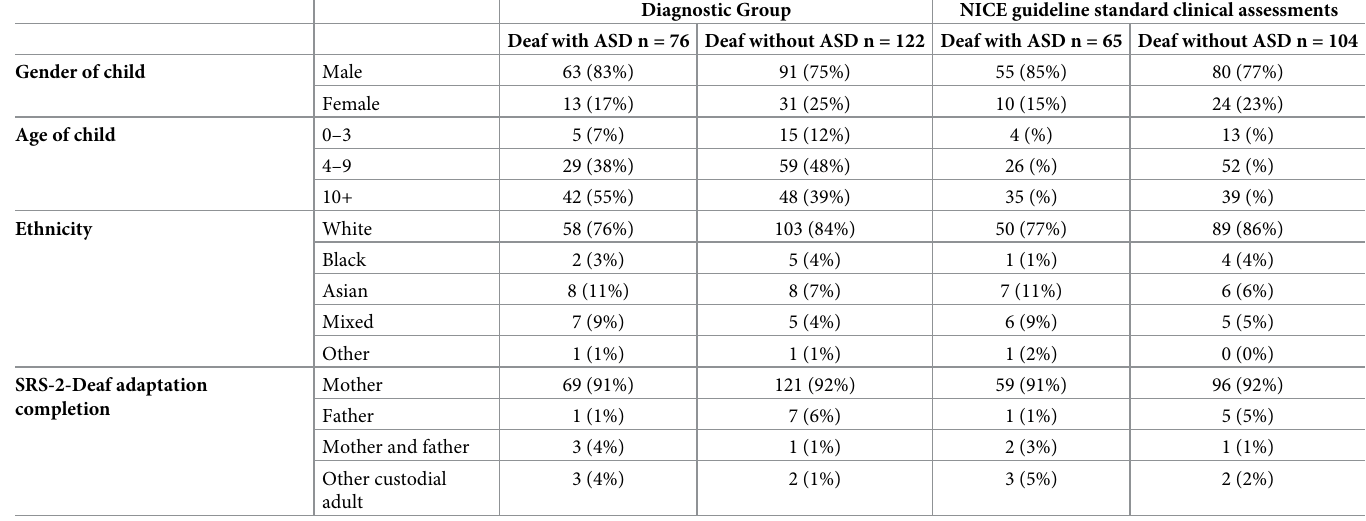
Table 3. Demographic characteristics of children and young people included in validation of the SRS-2 Deaf adaptation.